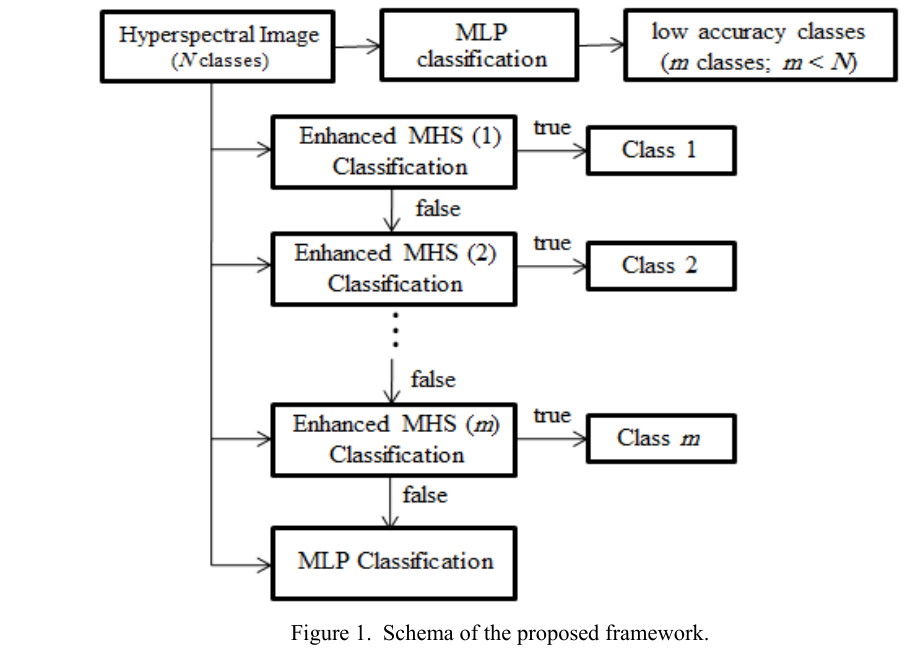
Figure 1. Schema of the proposed